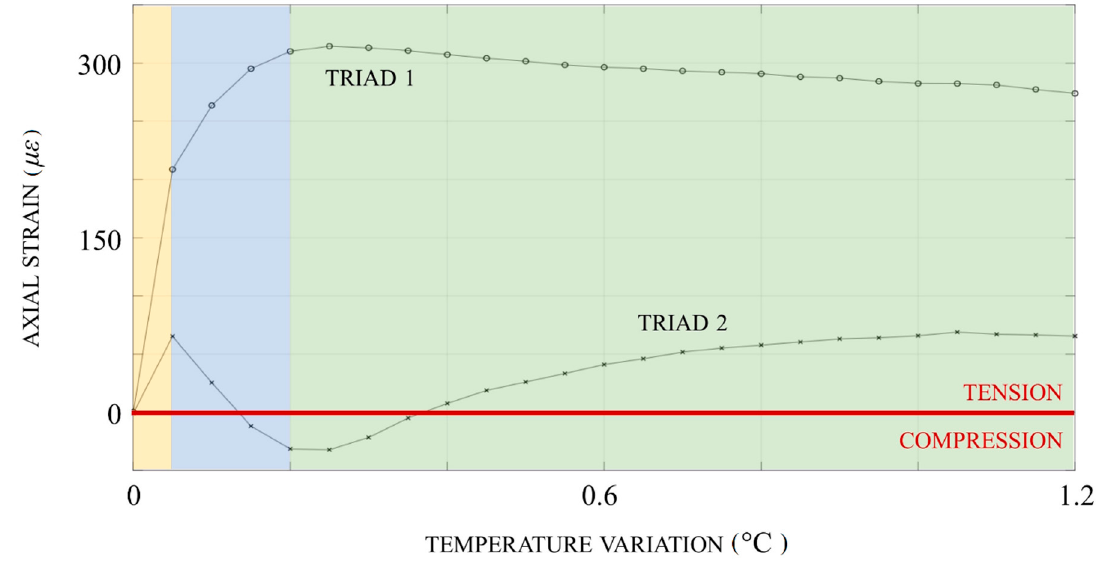
Figure 6. Axial strain vs. temperature rise: tension, encountered in the inceptive stage (yellow area), was gradually counterbalanced by the reaction of the constraint at the outlet, perceived first by Triad 2, undergoing sudden compression (blue area), which was subsequently released (green area).